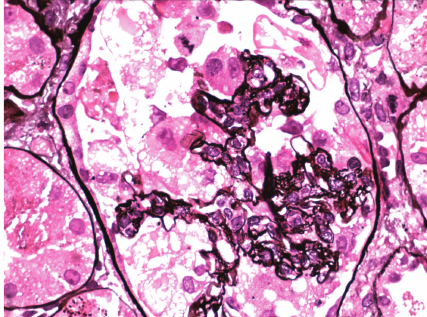
Figure 2: Light microscopy again showing collapsing focal segmen- talglomerulosclerosiswithmesangialhypercellularityandglomeru- lar capillary collapse.